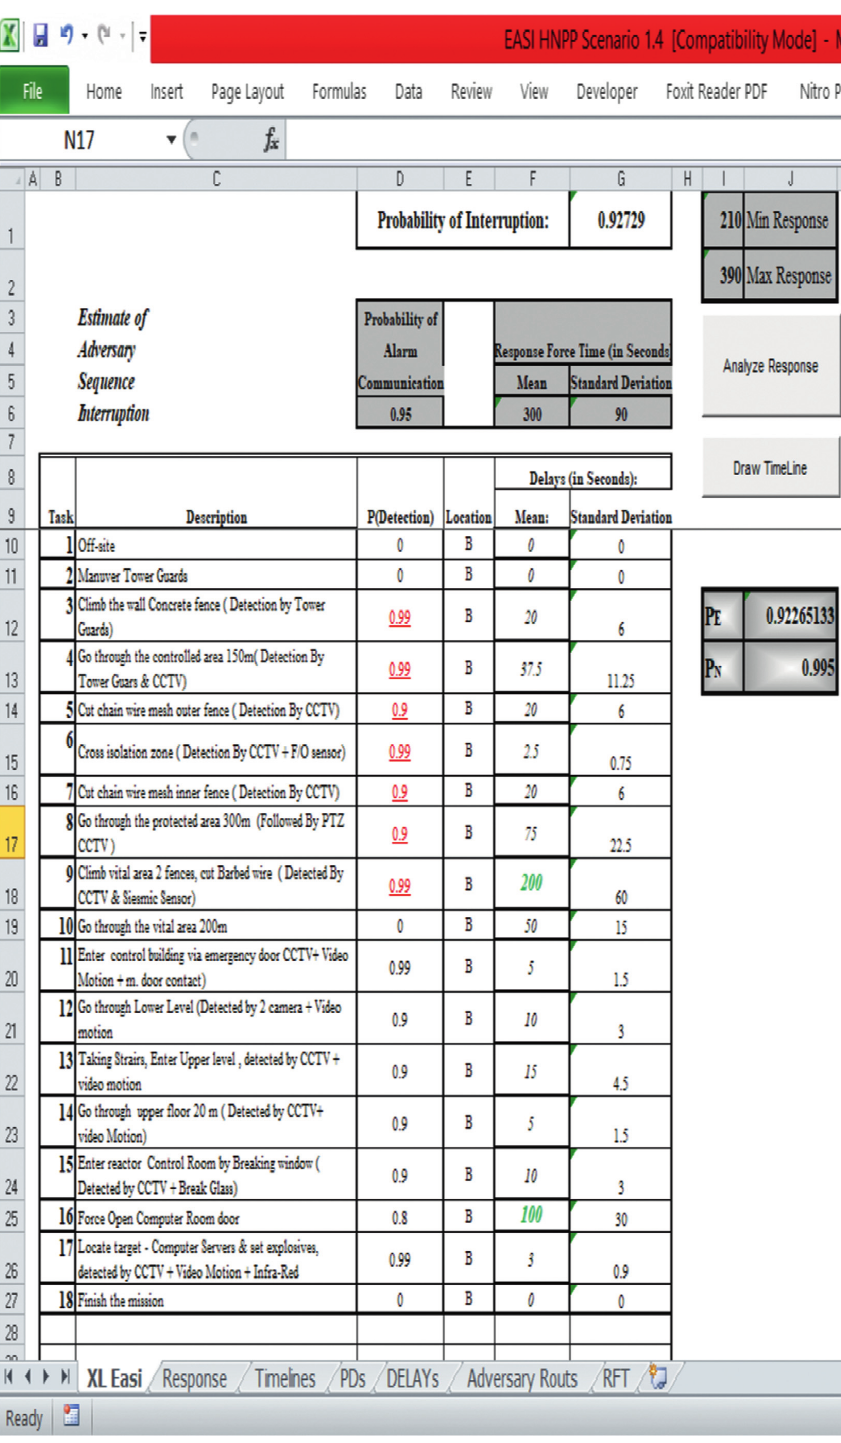
P � 0.922, increased and E for scenario 1.4, where E result